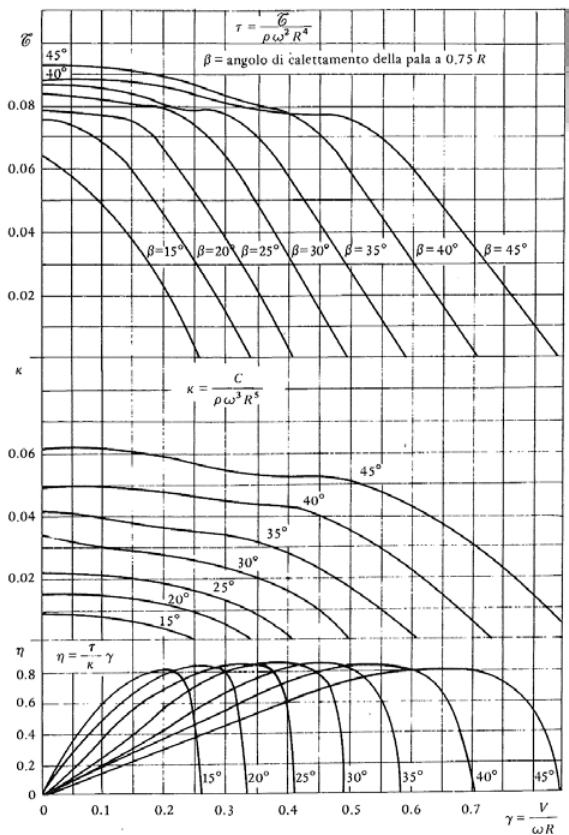
Fig. 10. Propeller diagrams. From (Lausetti